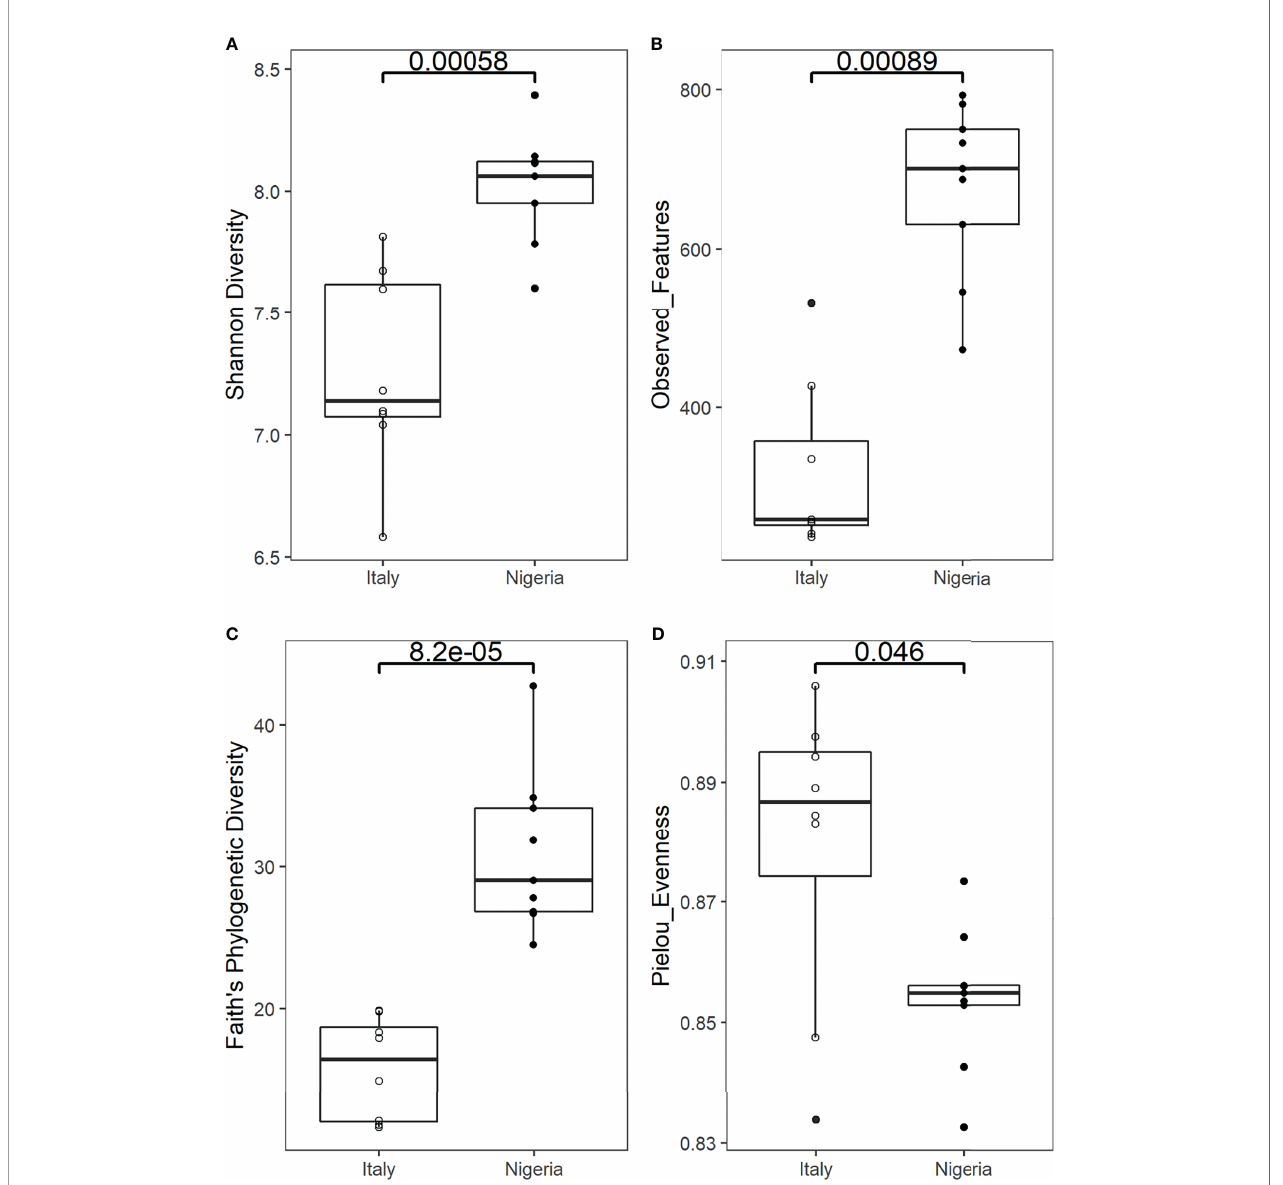
FIGURE 1 | Alpha diversity of an individual ’ s gut microbiota during a 2-month stay in Italy, and back to Nigeria. Boxplots show a signi fi cantly higher Shannon diversity (A) , number of observed ASVs (B) and Faith ’ s phylogenetic diversity (C) , while a signi fi cantly lower Pielou ’ s evenness index (D) in the faecal microbiota of samples collected from Nigeria (n=9) compared to Italy (n=9) (p = 0.00058, p = 0.00089, p = 0.000082 and p = 0.046, respectively). Statistical test: Wilcoxon rank sum